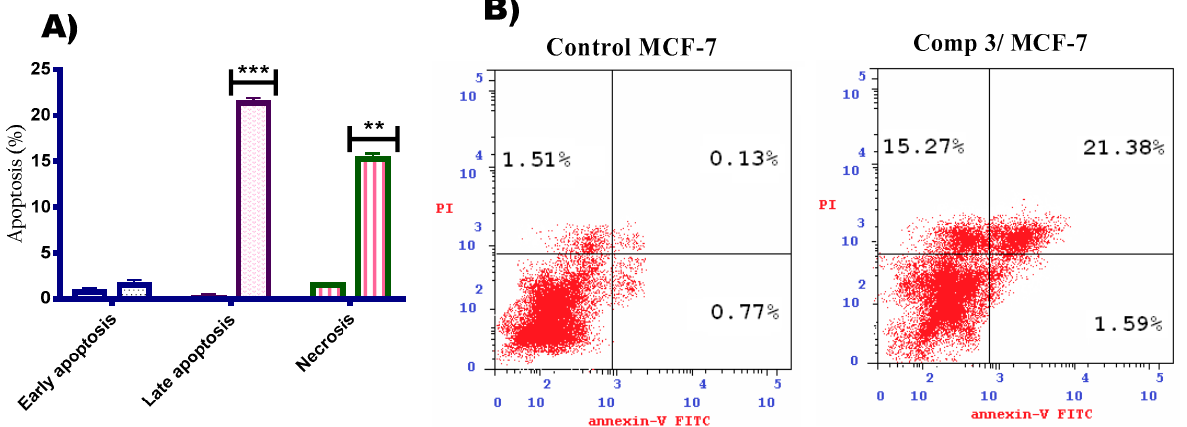
Figure 5. ( A ) Graphical representation of the effect of compound 3 on induction of apoptosis in MCF-7 cell line. ( B ) Effect of compound 3 on induction of apoptosis in MCF-7 cell line. Data are expressed as the mean ± SD ( n = 3 experiments) and statistical comparisons were carried out using one-way analysis of variance (ANOVA) followed by Tukey’s multiple comparison test (** p < 0.01, and *** p < 0.001). The lower left quadrant shows live cells; the lower right quadrant shows early apoptotic cells; the upper right quadrant shows late apoptotic cells; and the upper left quadrant shows necrotic cells.